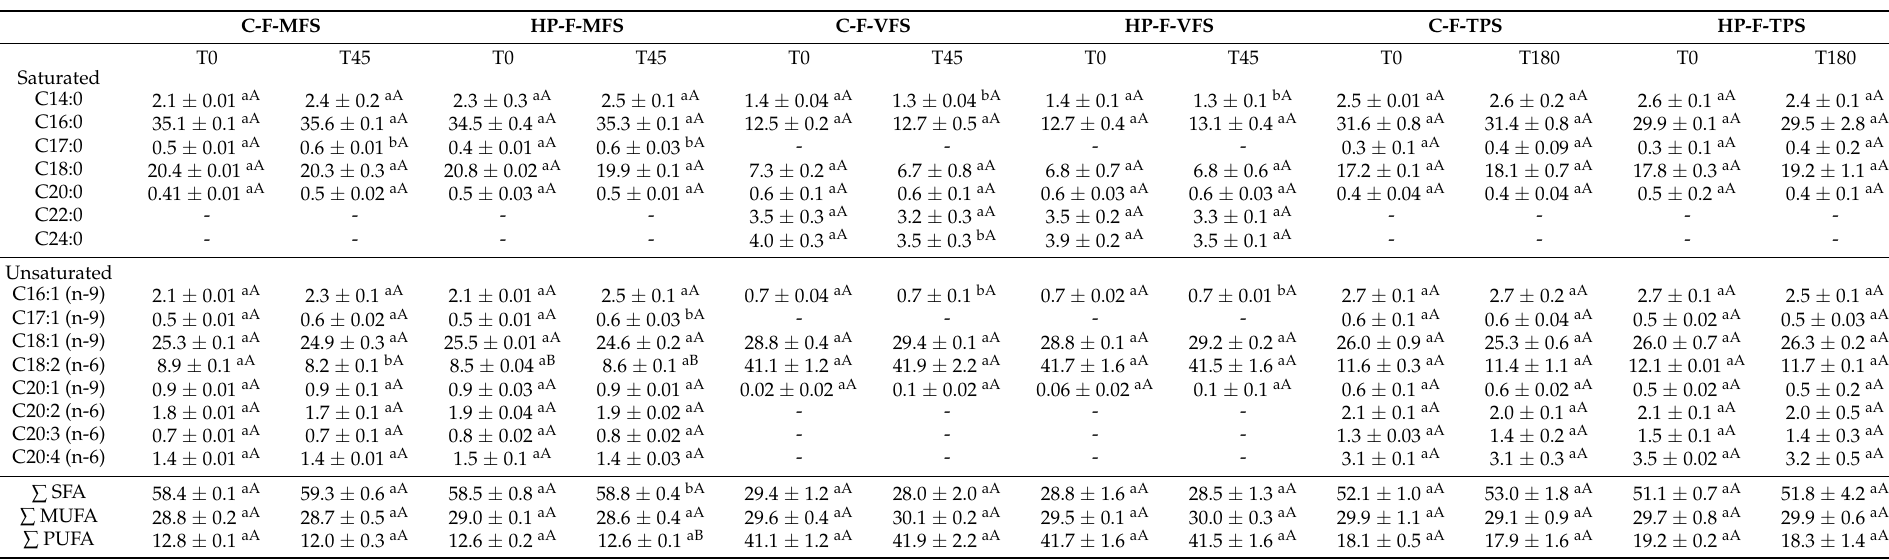
Table 2. Fortified foods fatty acids composition (% of total fatty acids), at the different processing conditions (non-pressurized and